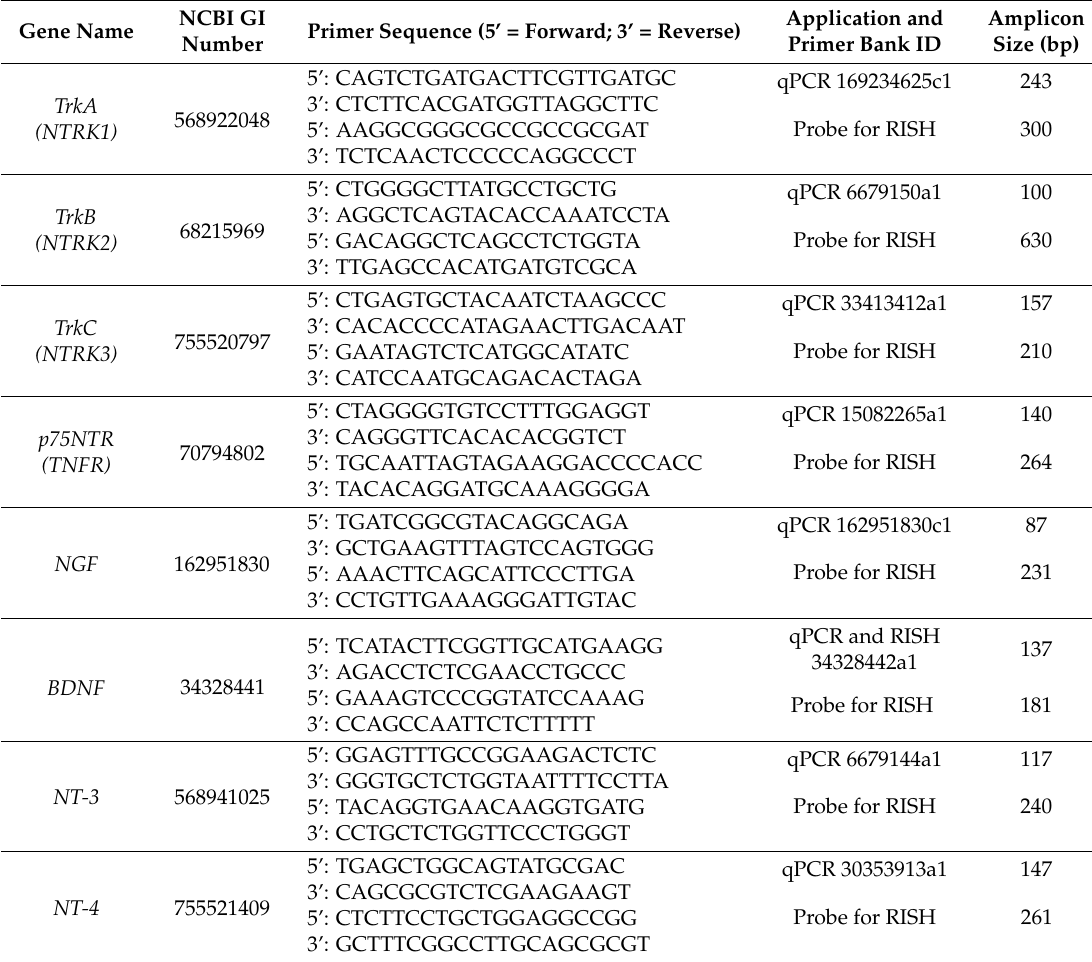
Table 1. Oligonucleotide primer sequences used for real-time qPCR and RISH analyses of gene transcript expression of NTs and